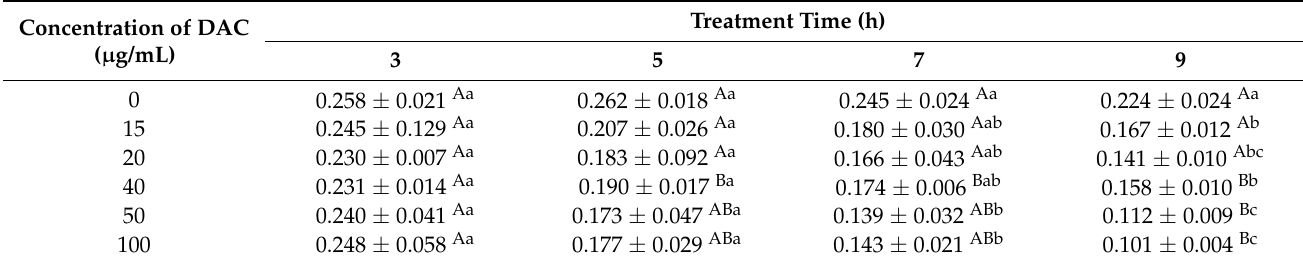
Table 15. The effect of DAC on content of MDA in GMEC (nmol/mL).